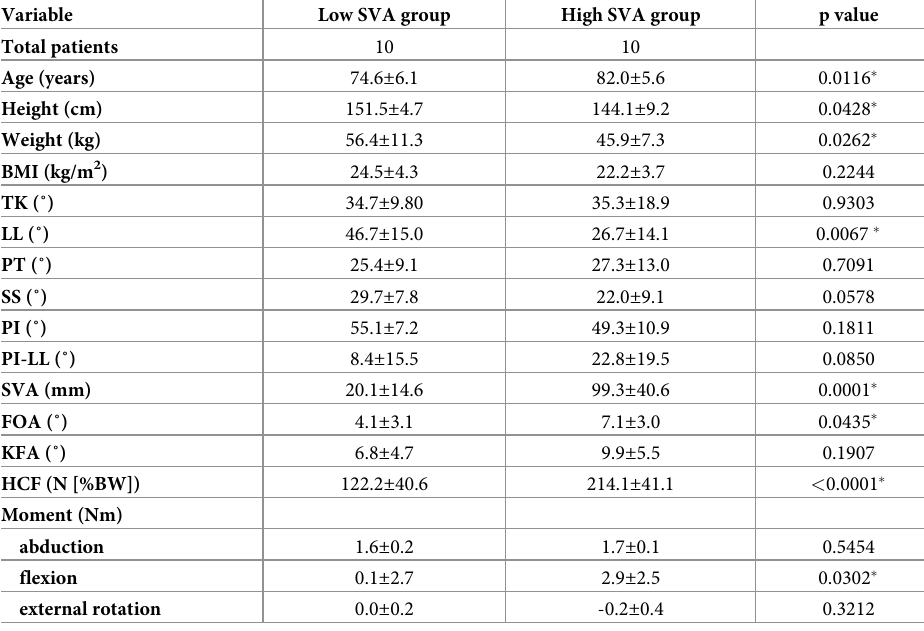
Table 3. Comparison of the low SVA and high SVA groups. Variable Low SVA group High SVA group p value Total patients